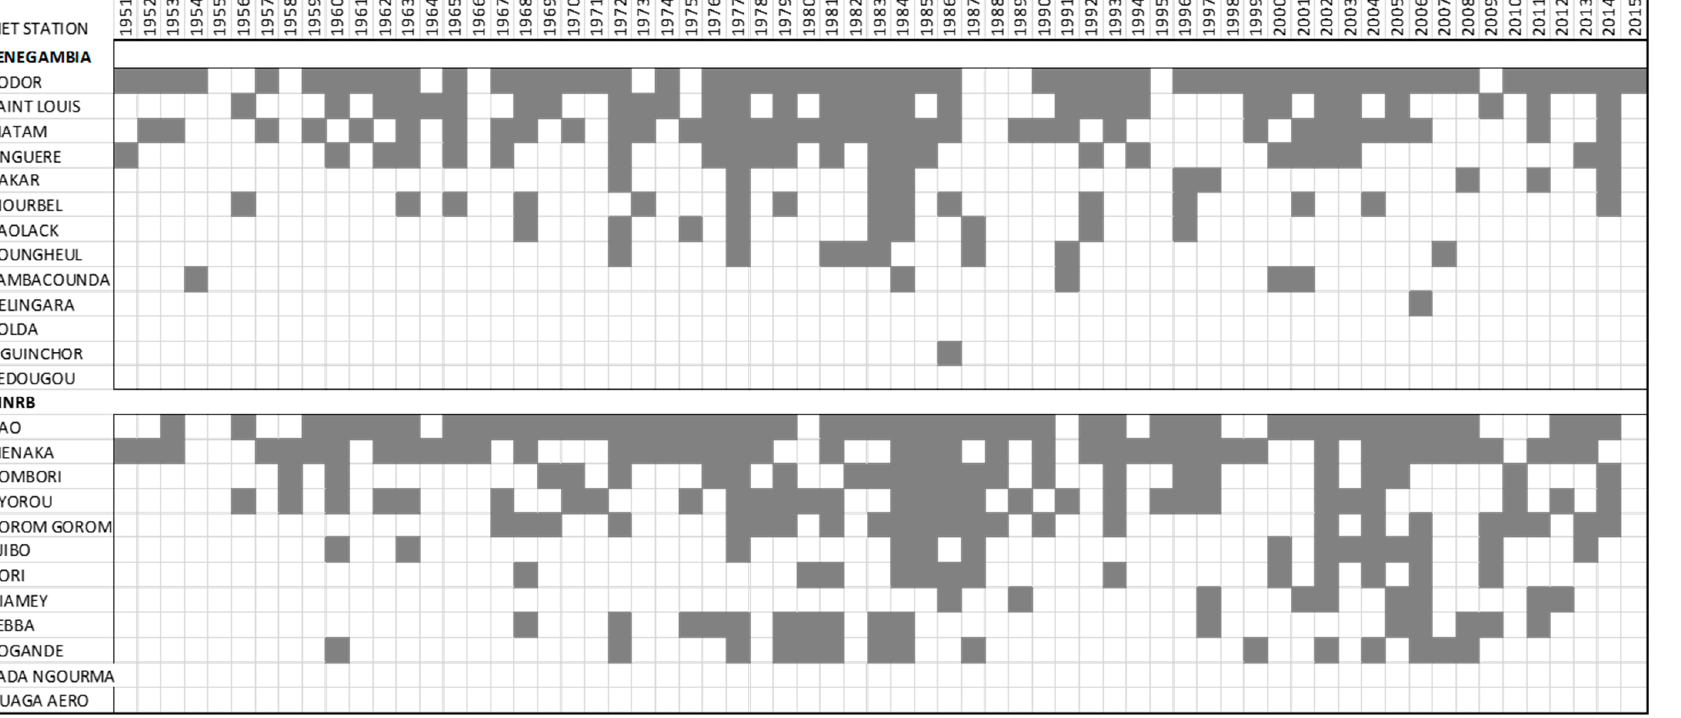
Figure 13. Spatio-temporal frequency of “missed” monsoons (black squares) in Senegambia (up) and Middle Niger River basin (bottom) from 1951 to 2015; in both areas, the stations are located in the table from the north to the south; “missed” according to the criteria defined by Sivakumar [116]: no event of more than 20 mm occurred that was not followed by a dry period longer than 7 days during the 1st month of the monsoon.